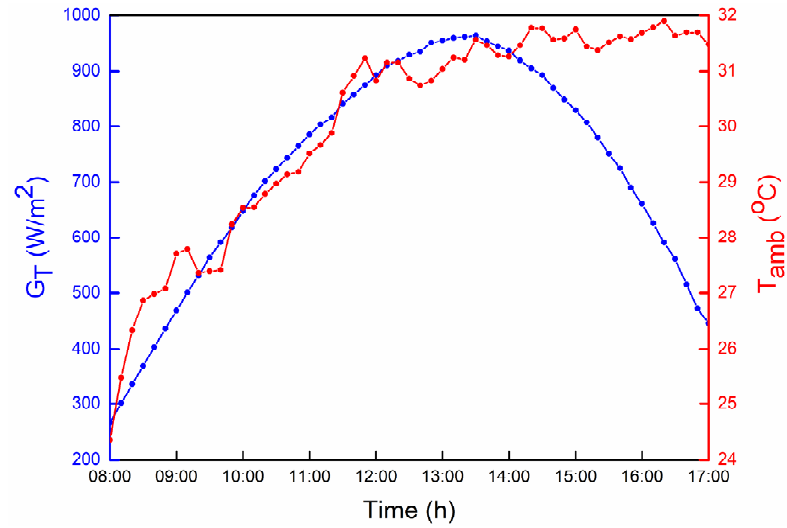
Figure 3. Variation of irradiance and ambient temperature with time during the experimental procedure.